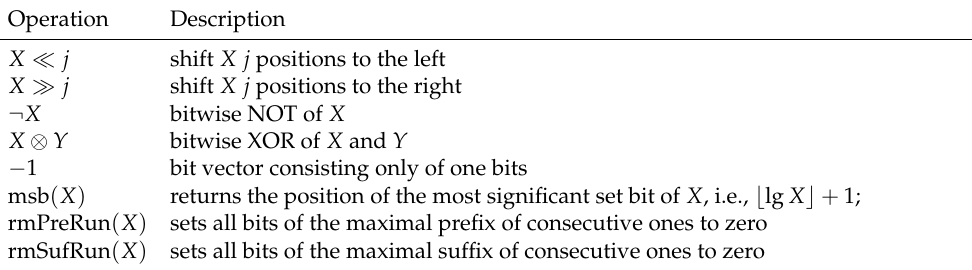
Figure 2. Operations used in Figures 4 and 5 for two bit vectors X and Y . All operations can be computed in constant time. See Figure 3 for an example of rmSufRun and